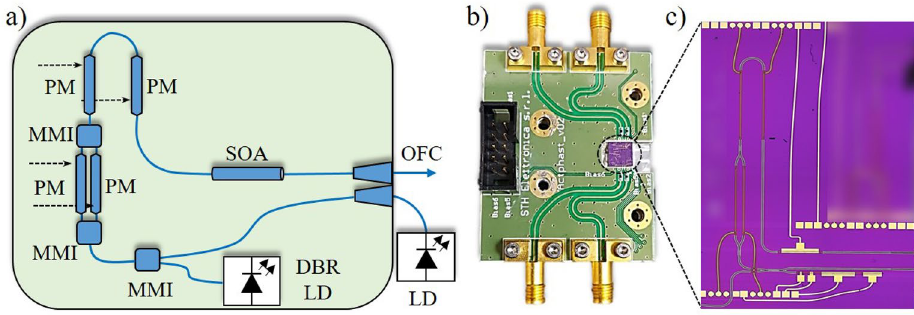
Figure 2. Indium phosphide monolithically integrated optical frequency comb based on cascaded modulators. ( a ) PIC schematic; ( b ) picture of the integrated OFC; ( c ) zoom-in-view of the chip on the metal chuck.